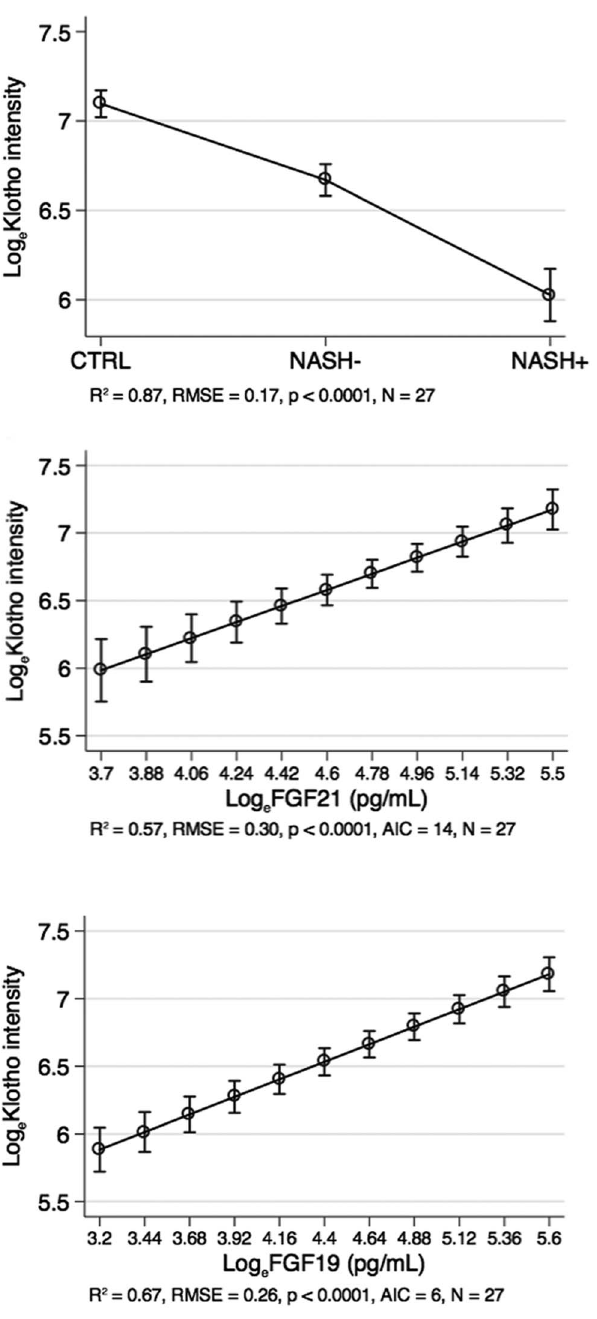
Figure 3. Association between the hepatic expression of Klotho, liver histopathology and serum FGF21 and FGF19. Association of Klotho with histopathology, FGF21 and FGF19 (see text for further details on statistical analysis). Abbreviations: log e =natural logarithm; RMSE=root mean squared error of the estimate; R 2 =coef- ficient of determination; AIC=Akaike information criterion. Circles are means and bars 95% confidence intervals.